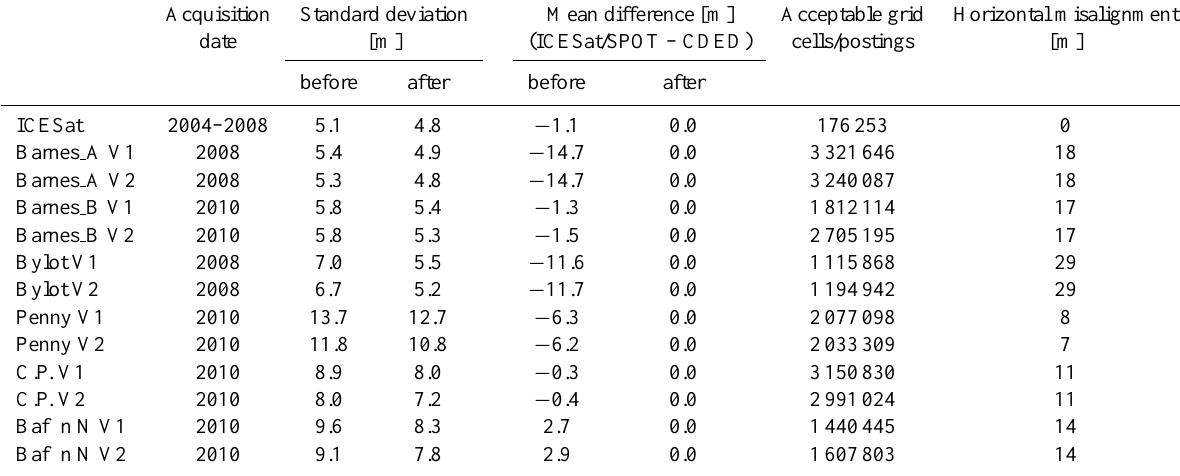
Table A2. Comparison of CDED with ICESat and SPOT elevations over ground before and after co-registration and elevation bias correc- tions. C.P. stands for Cumberland